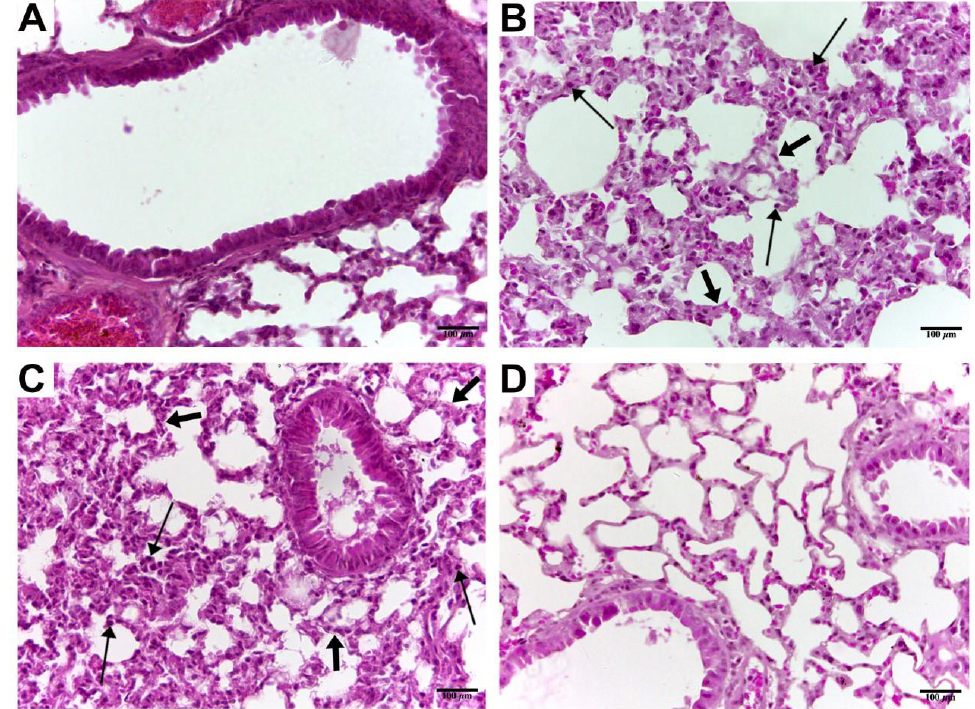
Figure 2. Histopathologic lungs analysis of animals after treatment. ( A ) Control lung section shows the normal structure of the bronchiole and adjacent alveoli. ( B ) Ibuprofen-treated mice representative lung section showing normal lung histology. ( C ) Diclofenac-treated mice lung tissue section showing normal bronchus and adjacent alveoli. ( D ) Paracetamol-treated mice lung tissue showing normal bronchial and alveolar tissues. Thick arrows indicate thickening in the alveolar wall; thin arrows indicate inflammatory cell infiltration. Tissue sections were stained with hematoxylin and eosin (scale bar 100 µm) and photographed at 40× magnification.